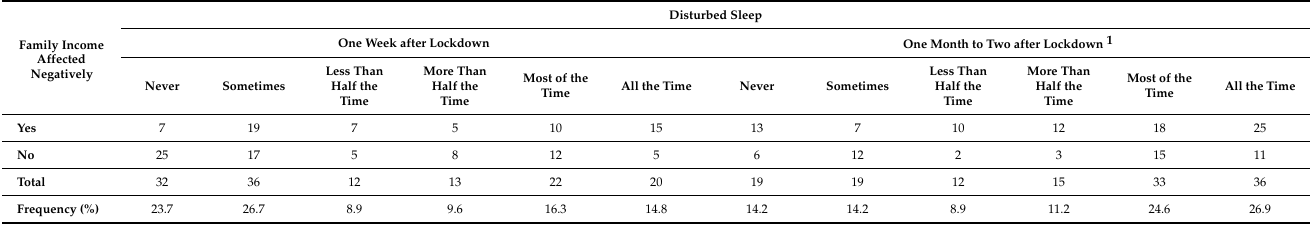
Table 3. Disturbed sleep and the negative effect on immediate family